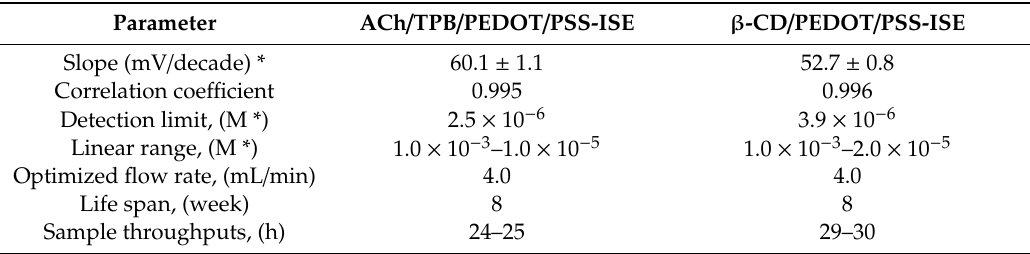
Figure 5. Flow injection signals for the evaluation of ACh + under the optimized flow injection conditions using: ( A ) ACh / TPB / PEDOT / PSS-ISE and ( B ) β -CD / PEDOT / PSS-ISE. Table 4. Flow-through response characteristics of acetylcholine membrane-based